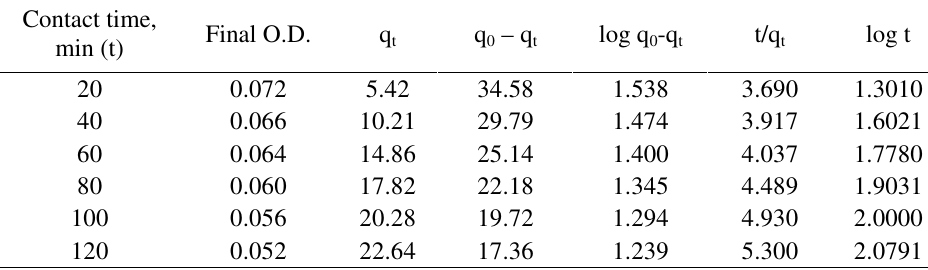
) = 40 ppm; O.D. for initial dye 0 ) = 0.008; q – q = 40.00 - 0.008 = 39.992) e 0 e